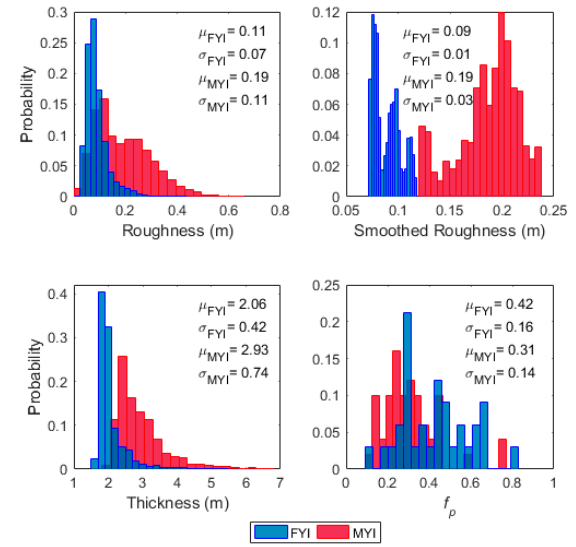
Figure 6. Winter sea ice surface roughness ( top left ), smoothed surface roughness ( top right ), winter sea ice thickness ( bottom left ) and spring f p ( bottom right ) distributions. FYI is shown in blue and MYI in red. Mean ( μ ) and standard deviations ( σ ) are given by ice type. f p distributions were calculated using hybrid-object aggregation at the medium scale.